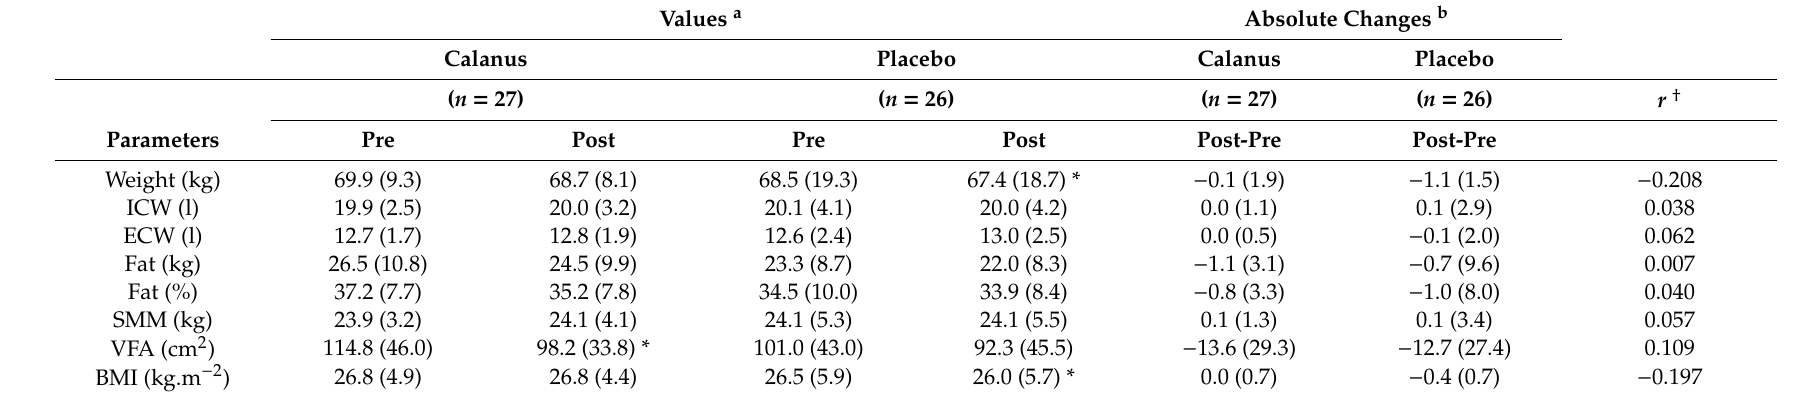
Table 3. Comparison of body composition within groups and between